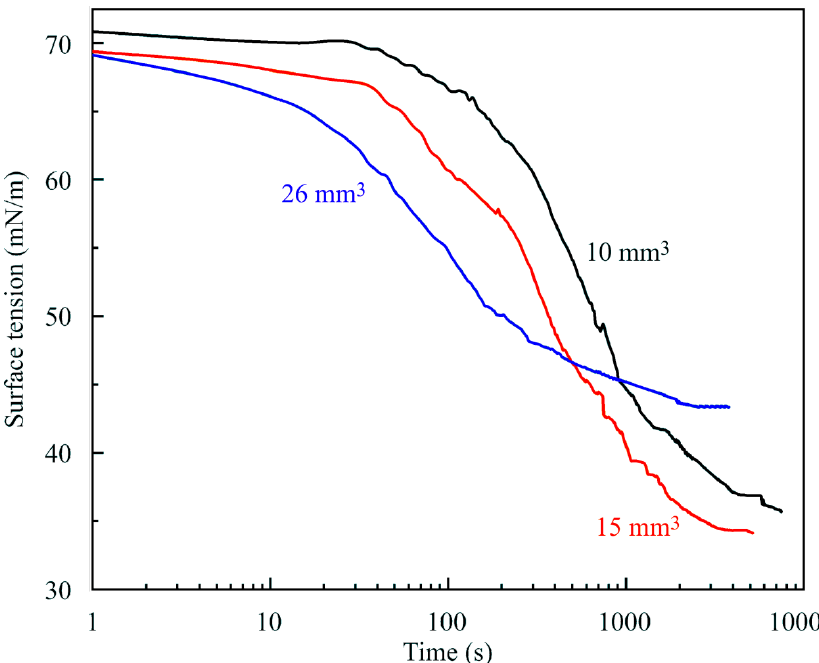
Figure 7. Dynamic (apparent) surface tensions for a 1 μmol/L aqueous C 14 EO 8 solution at three different volumes of the drop.